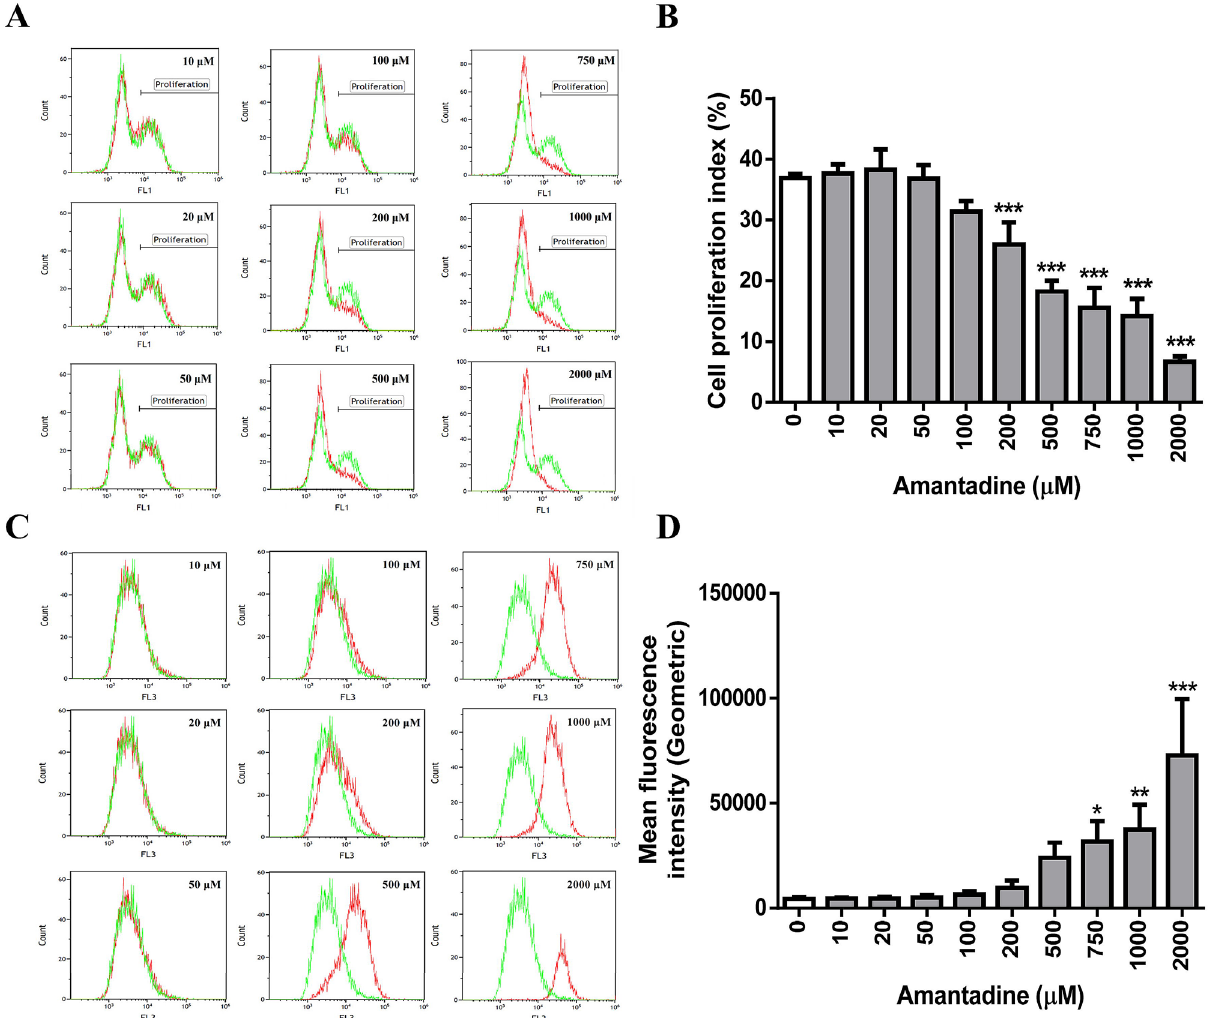
Figure 5. Effect of amantadine HCl on cell proliferation in bovine cornea endothelial cells. BCE C/D-1b cells were treated with different concentrations of amantadine HCl (0–2000 μM) for 24 h. ( A ) The DNA synthesis was examined by EdU incorporation assay. Overlay of the histograms of untreated cells (green) and cells treated with amantadine HCl (red). ( B ) The cell proliferation index was quantified and the statistical significance was represented as follows: **p < 0.01 vs. untreated control. BCE C/D-1b cells were labeled with 1 μΜ CFSE for 10 min and then treated with different concentrations of amantadine HCl (0–2000 μM) for seven days. ( C ) The results are representative of three independent experiments. The CFSE histograms of amantadine HCl treated cells (red) were overlaid with untreated cells (green). ( D ) Statistical analysis was carried out from three independent experiments. Data are presented as means ± SD and the statistical significance was represented as follows: *p < 0.05, **p < 0.01 and ***p < 0.001 vs. untreated